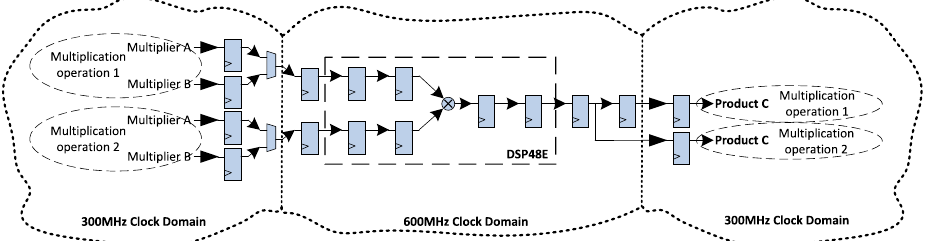
Figure 13. DSP48E Cross-Clock Domain Design.